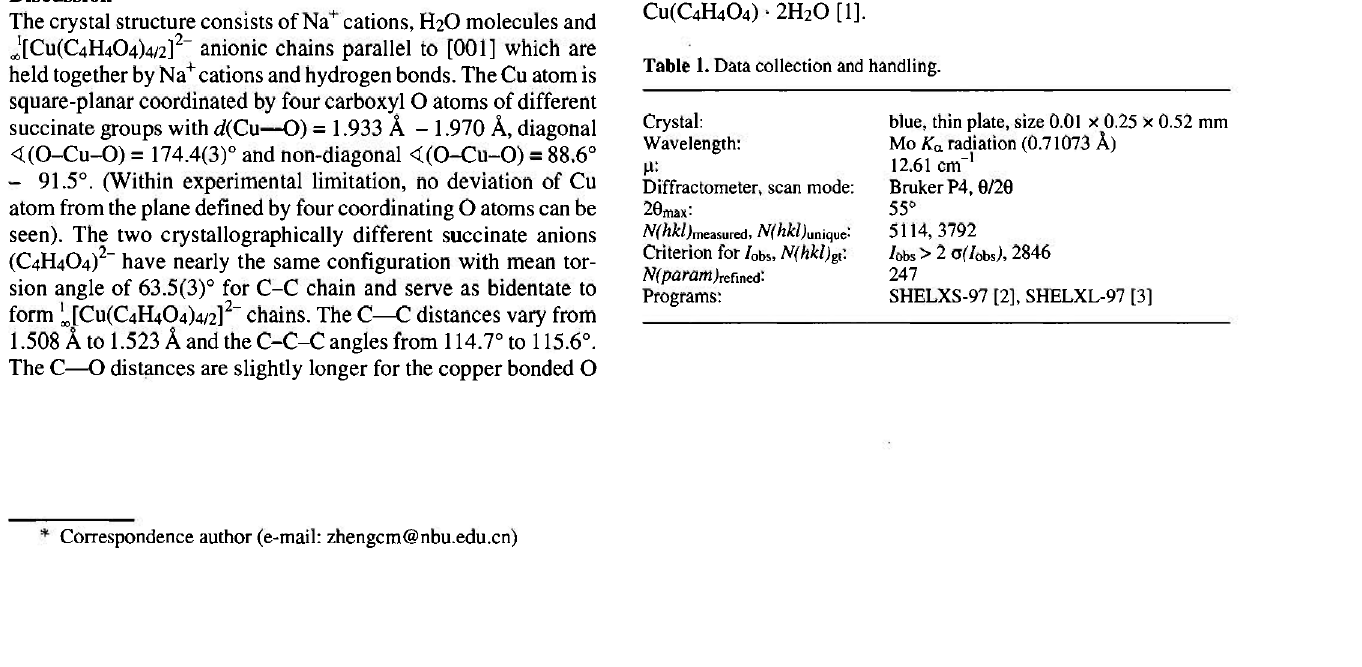
Table 1. Data collection and handling.